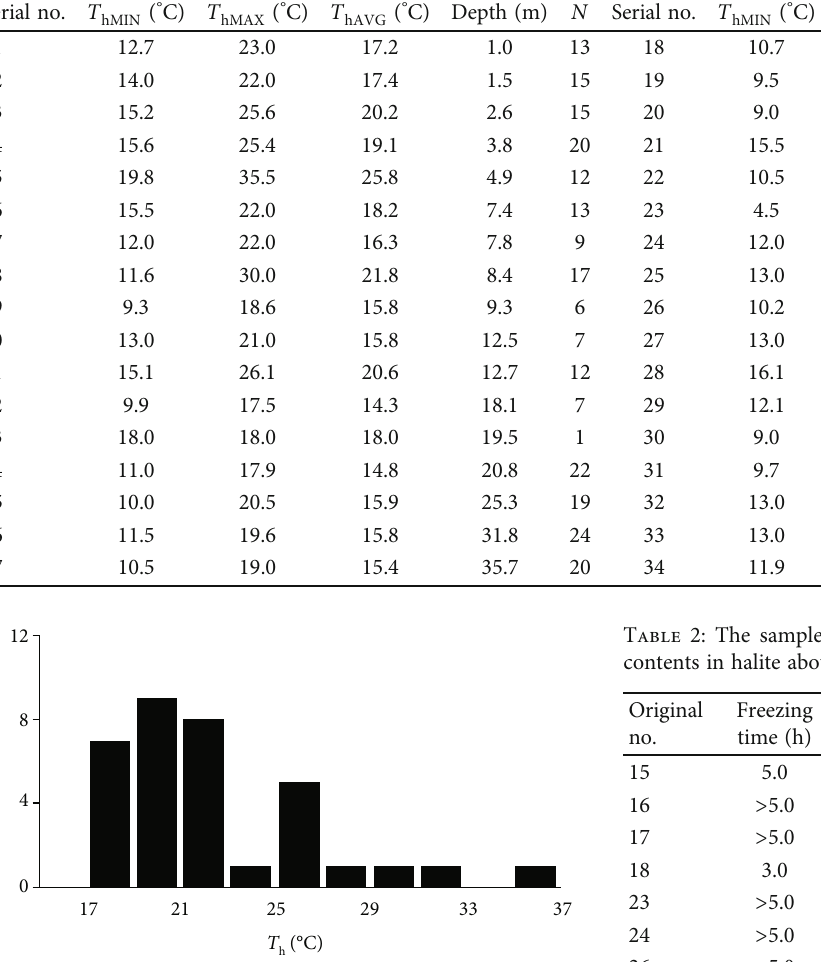
Table 1: Summary of homogenization temperatures of halite fl uid inclusions.